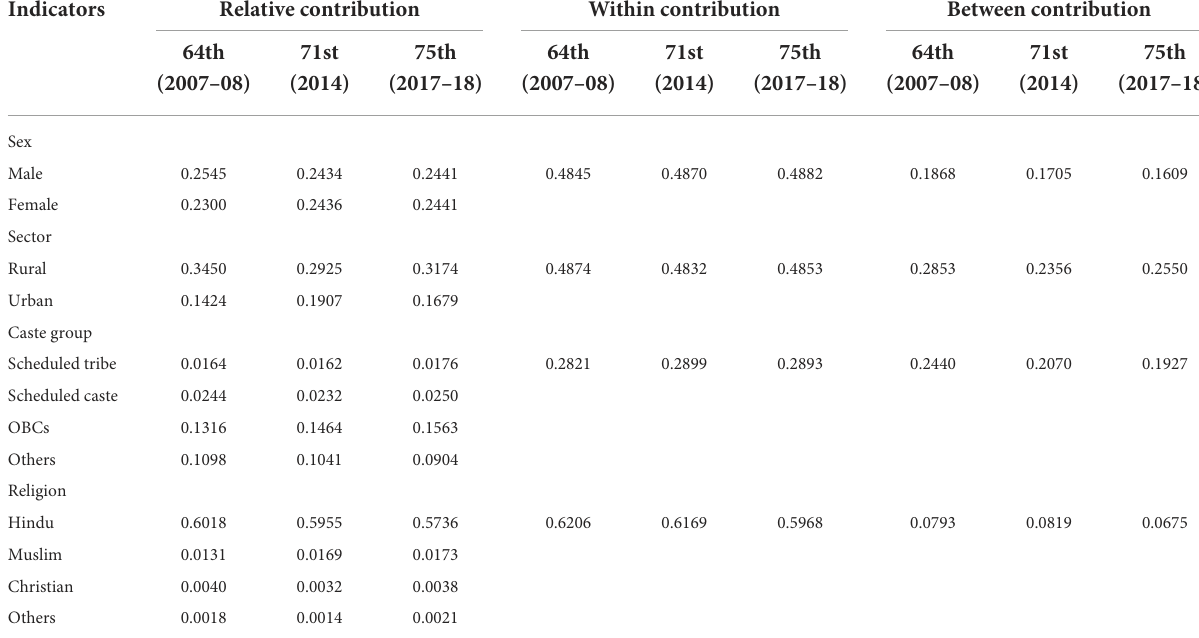
TABLE 6 Decomposition of Gini by